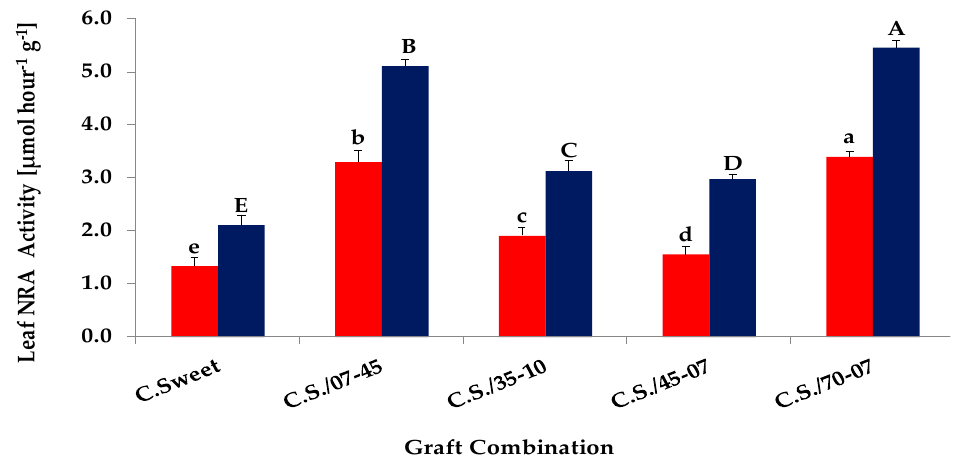
Figure 4. Leaf NRA activity of non-grafted and grafted watermelon cultivar (Crimson Sweet) onto gourd genotypes grown under low (0.3 mM) and high (3.0 mM) N supply in Expt. 2 . Values denoted by different letters (lower- and upper-case letters for low and high N supply, respectively) are significantly different between genotypes within columns at p < 0.05. ns, non-significant. * p < 0.05, **P < 0.01